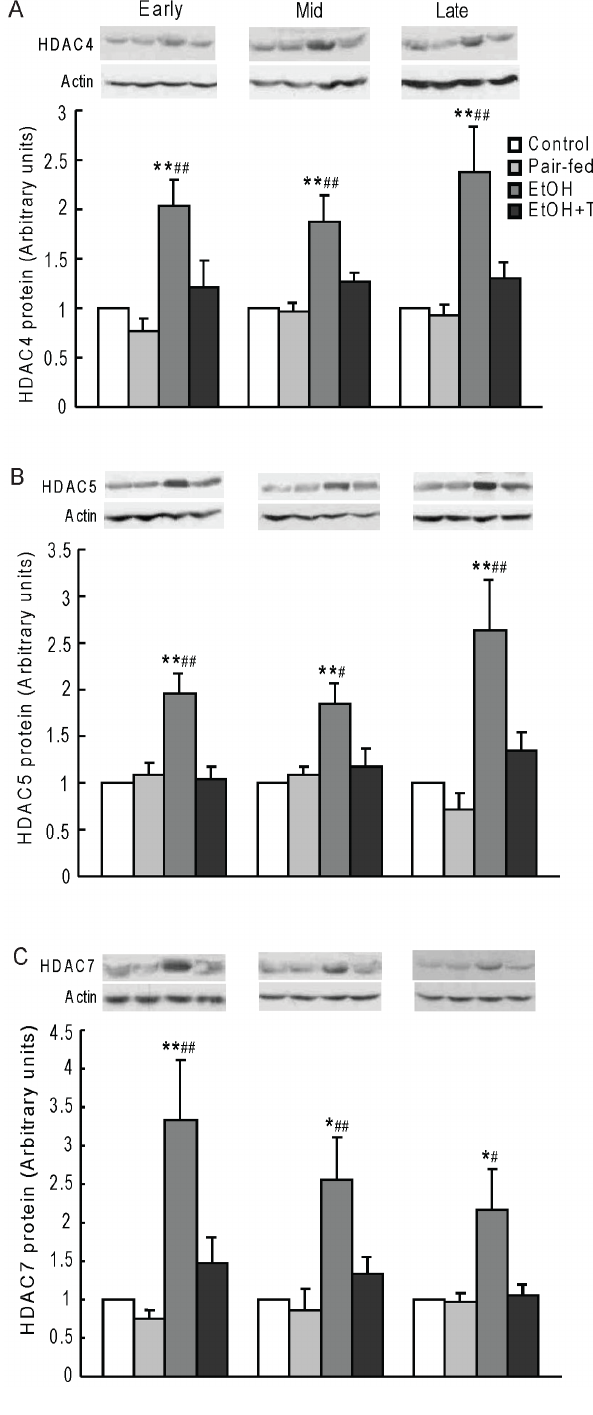
Figure 5. Hepatic nuclear HDAC4 (A), HDAC5 (B), and HDAC7 (C) protein levels in 4 month-old male rat offspring exposed to ethanol (EtOH) or water only during early, mid, or late pregnancy. Control and pair-fed offspring were from dams with free access to chow and dams fed the amount of chow consumed by EtOH dams, respectively. A subgroup of EtOH rats was given TUDCA (T) 3 weeks before the experiments. Data shown as the mean 6 SE, n=6. *P , 0.05, **P , 0.01 EtOH vs. control; # P , 0.05, ## P , 0.01 EtOH vs. pair- fed.